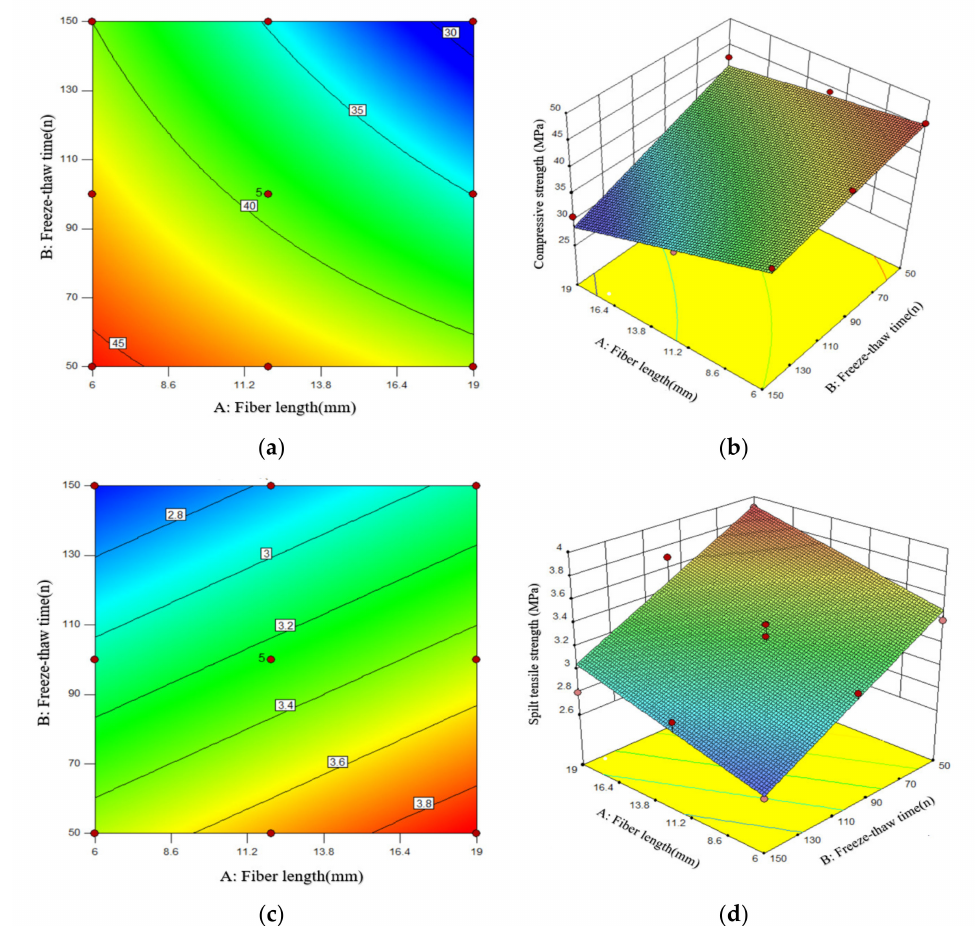
Figure 9. Effects of Factor A, B, and their interactions on R.(PFMSC): ( a ) Surface diagrams of compressive strength variation with A and B (2D), ( b ) Surface diagrams of compressive strength variation with A and B (3D), ( c ) Surface diagrams of split tensile strength variation with A and B (2D), ( d ) Surface diagrams of split tensile strength variation with A and B